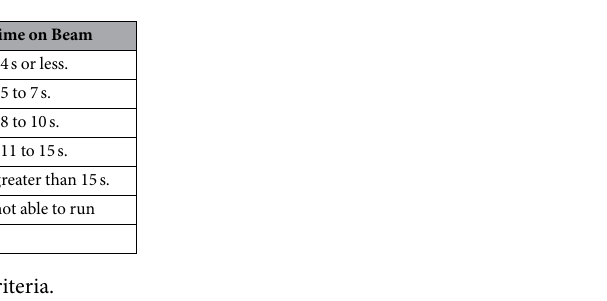
Table 2. The Beam Walk Test Scoring